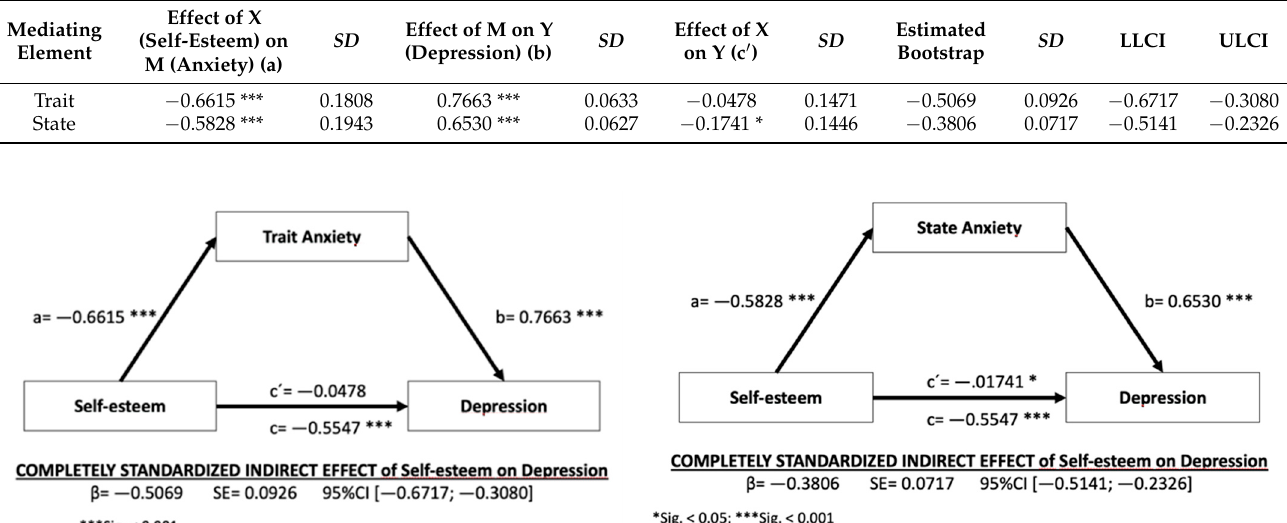
Figure 2. Mediation models under analysis. Note: a, b, c´ = direct effects; c = total effect.